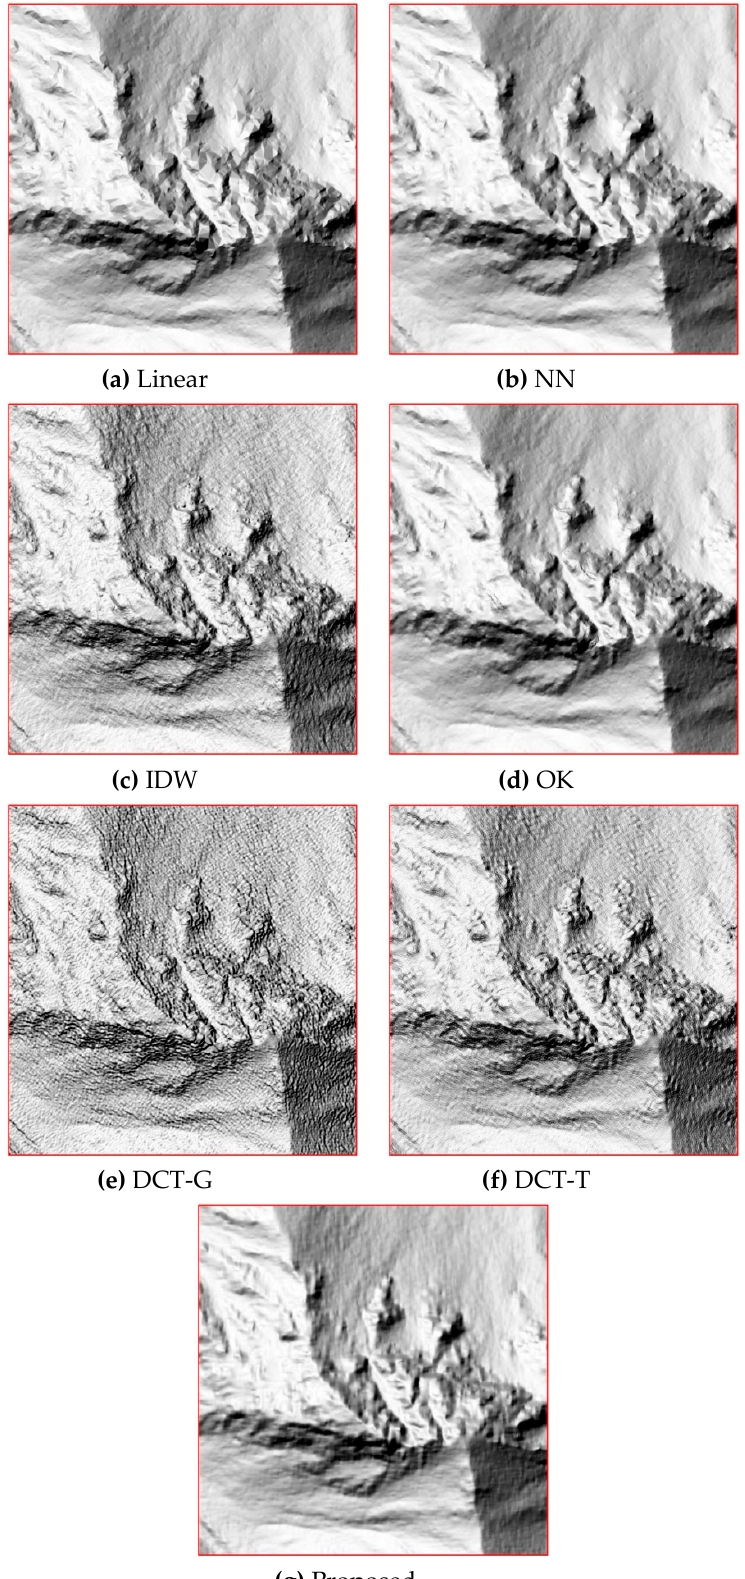
Figure 11. Shaded relief maps of the proposed method and the other interpolation methods on 30% of the training points.